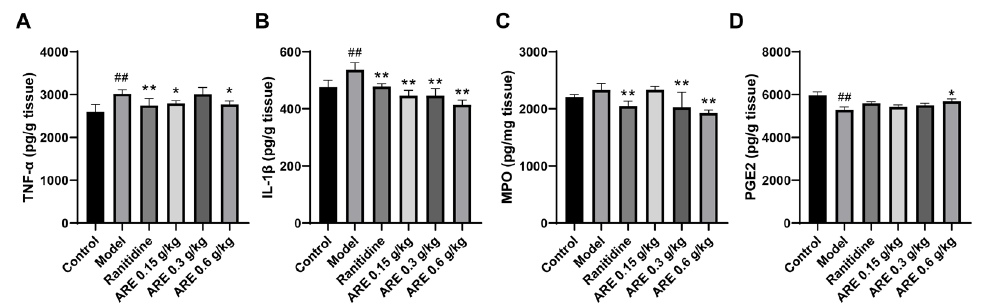
Figure 10. The effects of ARE on TNF- α, IL - 1β, MPO , and PGE2 in gastric tissue. ( A ) TNF- α . ( B ) IL- 1β . ( C ) MPO. ( D ) PGE2. ## p < 0.01 when compared with the control group; * p < 0.05, ** p <